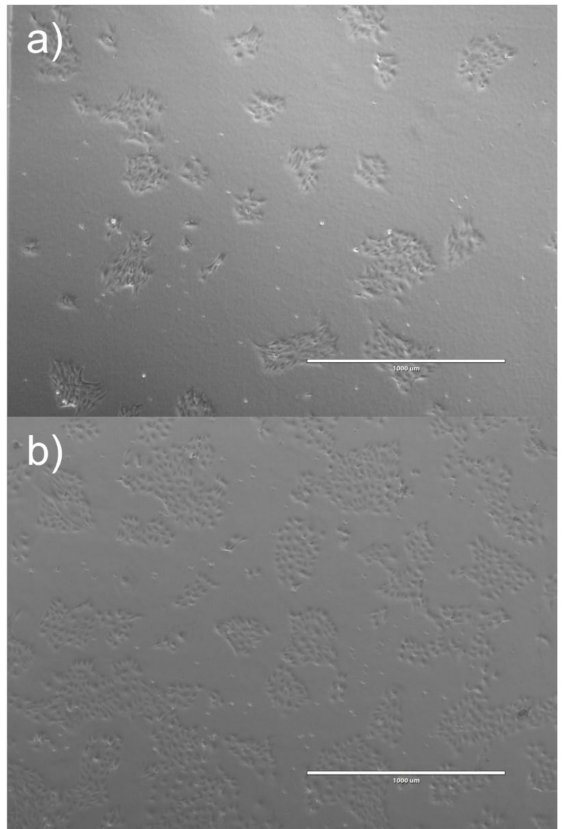
Figure A1. Colony forming ability of endothelial-like cells (ELC) at ( a ) passage 3, and ( b ) passage 4. Phase contrast images. Scale bars are 1000 µ